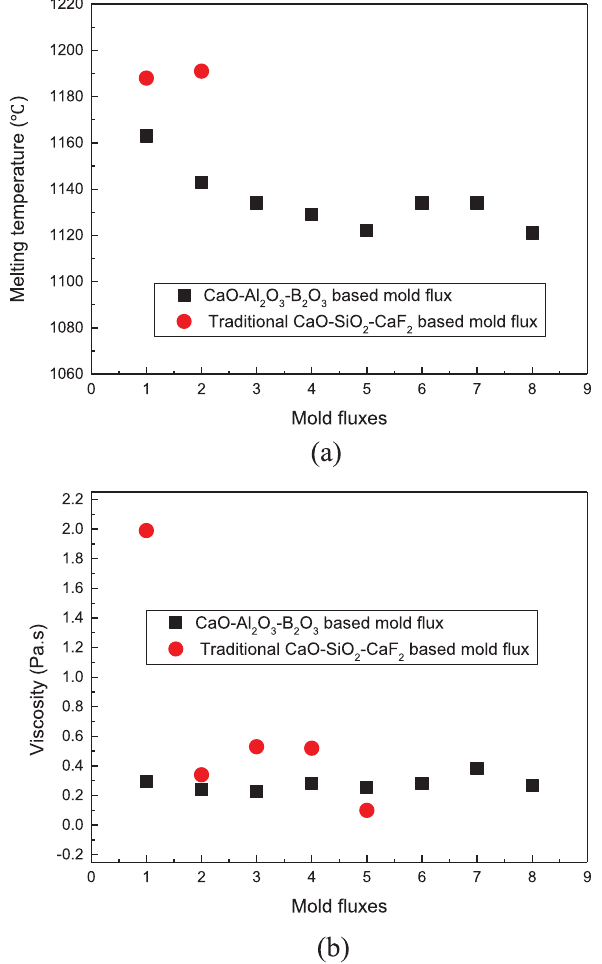
Figure 1: Comparison of the melting temperatures and viscosities of the studied CaO-Al 2 O 3 -B 2 O 3 -based mold flux with traditional CaO- SiO 2 -CaF 2 -based mold flux [19].